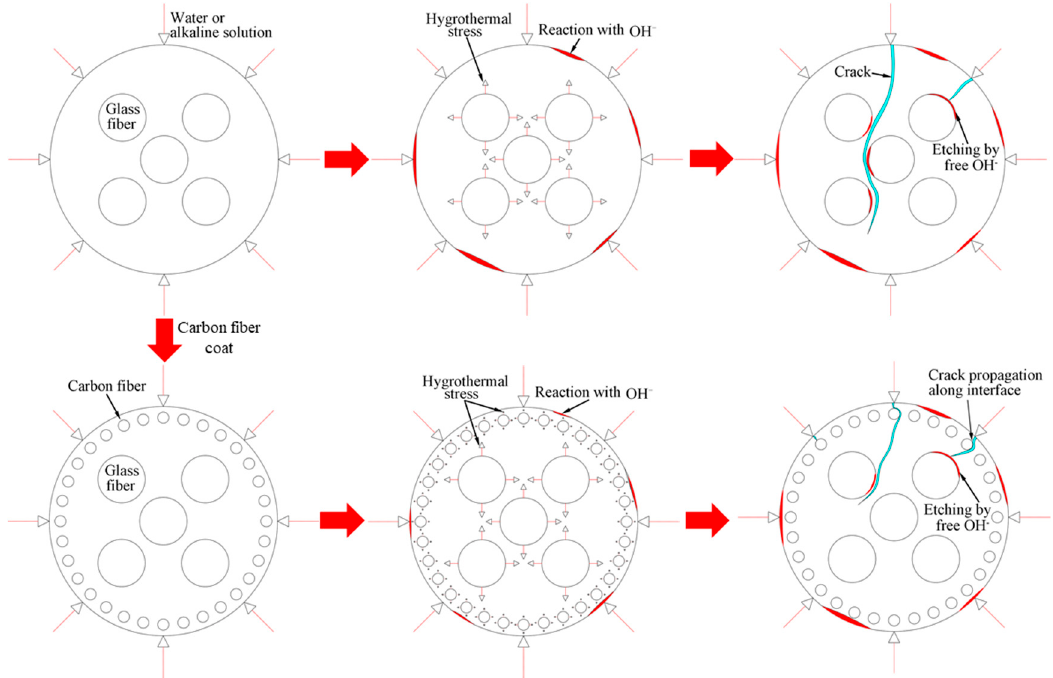
Figure 12. The failure mode of the specimens at a temperature of 60 °C: ( A ) the GFRP bars in water, ( B ) the HFRP bars in water, ( C ) the GFRP bars in the alkaline solution, and ( D ) the HFRP bars in the alkaline